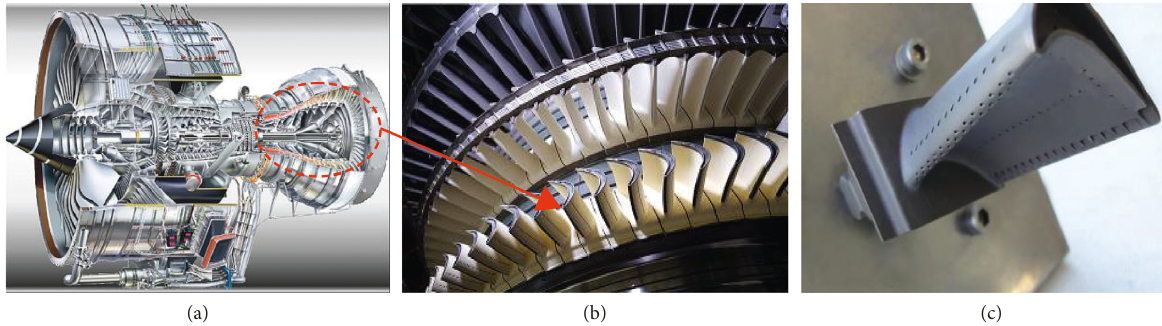
Figure 1: (a) Aircraft engine and (c) cooling holes on (b) the turbine blade’s